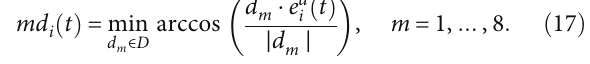
Algorithm 1 is used to update an individuals ’ position and velocity in each time step.